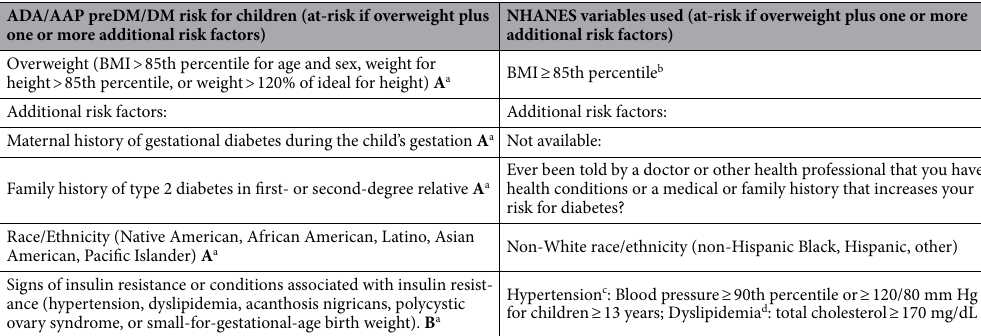
Table 1. Pediatric clinical screening guideline used to define prediabetes/diabetes (preDM/DM) status and their corresponding operationally defined equivalent variables in the National Health and Nutrition Examination Survey (NHANES). e a Evidence grades, with grade A and B representing higher and moderate quality evidence, respectively. Grades do not factor into the determination of risk in the current study. b We calculated BMI percentiles using the SAS program provided by the CDC for the 2000 CDC growth charts (ages 0 to < 20 years) with overweight/obese defined as > 85th percentile. Available from: https:// www. cdc. gov/ nccdp hp/ dnpao/ growt hchar ts/ resou rces/ sas. htm. c We calculated blood pressure percentiles for children (< 18 years) based on the 2017 Clinical Practice Guidelines from the AAP using the recommended published SAS program. Available from: https:// sites. google. com/a/ chann ing. harva rd. edu/ berna rdros ner/ pedia tric- blood- press/